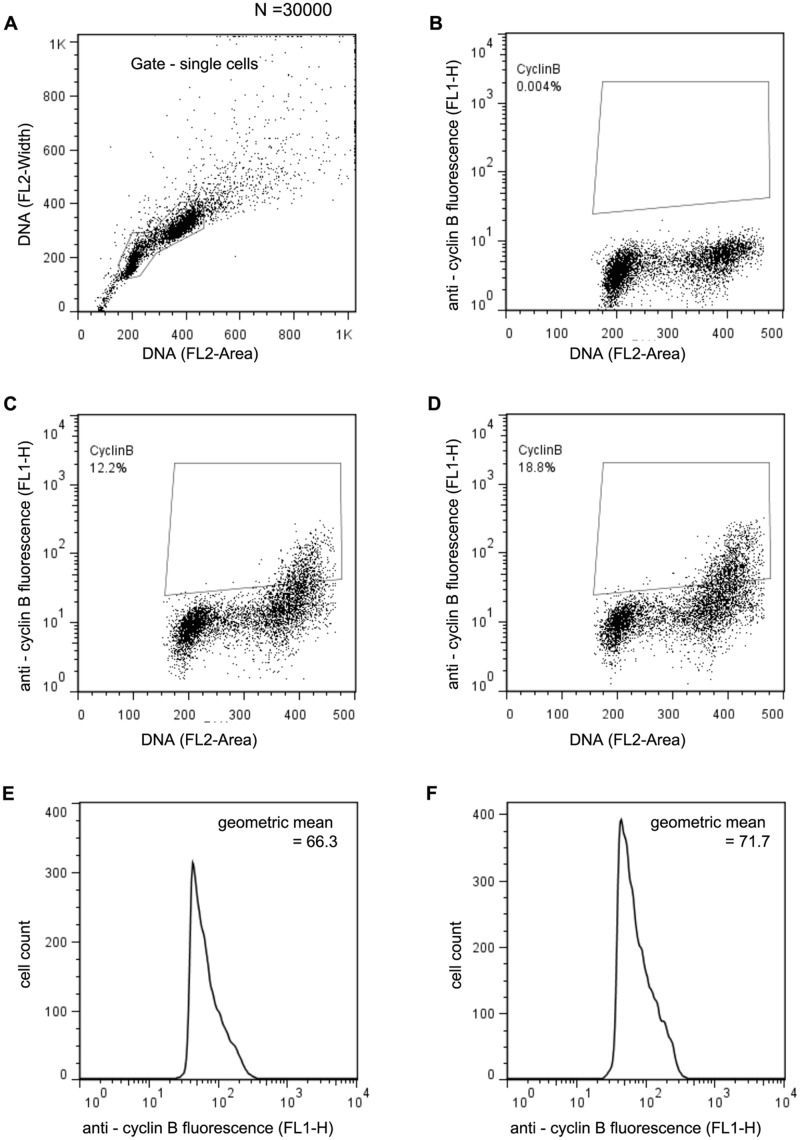
Inhibition of mitochondrial fusion influences mitosis through cyclin B.(A) Doublet-discrimination module operating on all events to identify single cells with unreplicated and replicated DNA on the basis of pulse area and pulse width using the DNA stained by propidium iodide to generate a signal. Gate identifies single cells used for further analysis. (B) Negative control for the cyclin B staining, shows S2R+ cells treated with secondary antibody but not the primary anti-cyclin B. Fluorescence detected (Y-axis) is non-specificty, and is used to determine the gate for the cyclin B positive population. (C) Controls (S2R+ cells treated with gfp dsRNA) contain 12.2% cyclin B positive cells. (D) In S2R+ cells depleted of mitofusin, the population of cyclin B positive cells increases to 18.8%. (E, F) The content of cyclin B in the positive population (gates in C, D) increases from 66.3 a.u (controls, E) to 71.7 a.u. upon depletion of mitofusin (F).